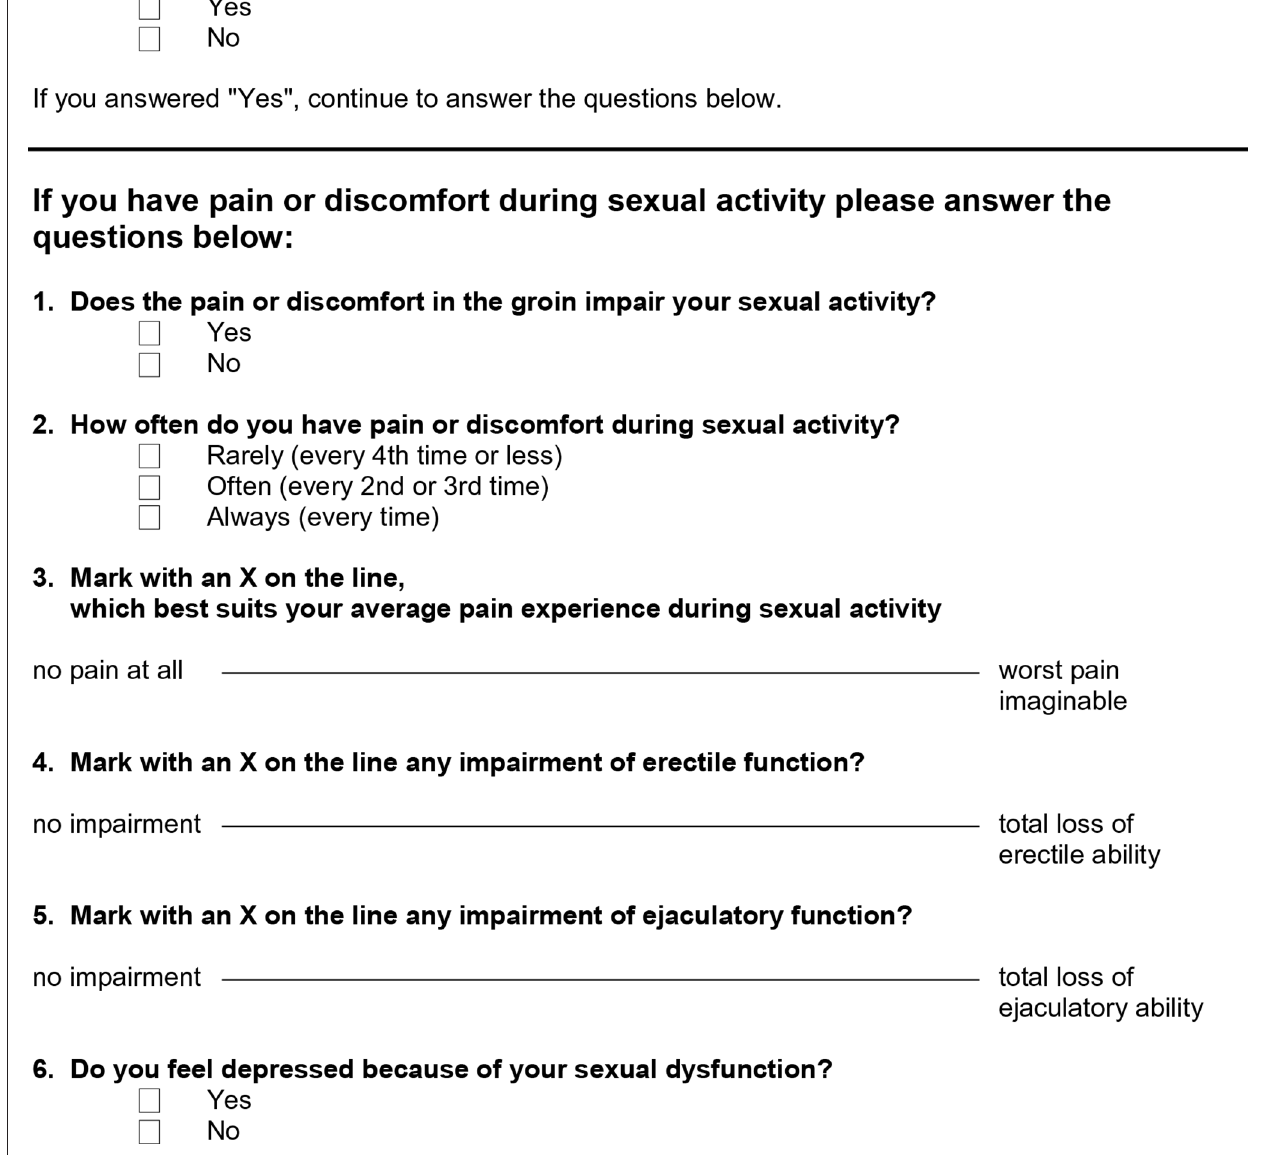
FigUre 2 | SexIHQ Questionnaire on pain during sexual